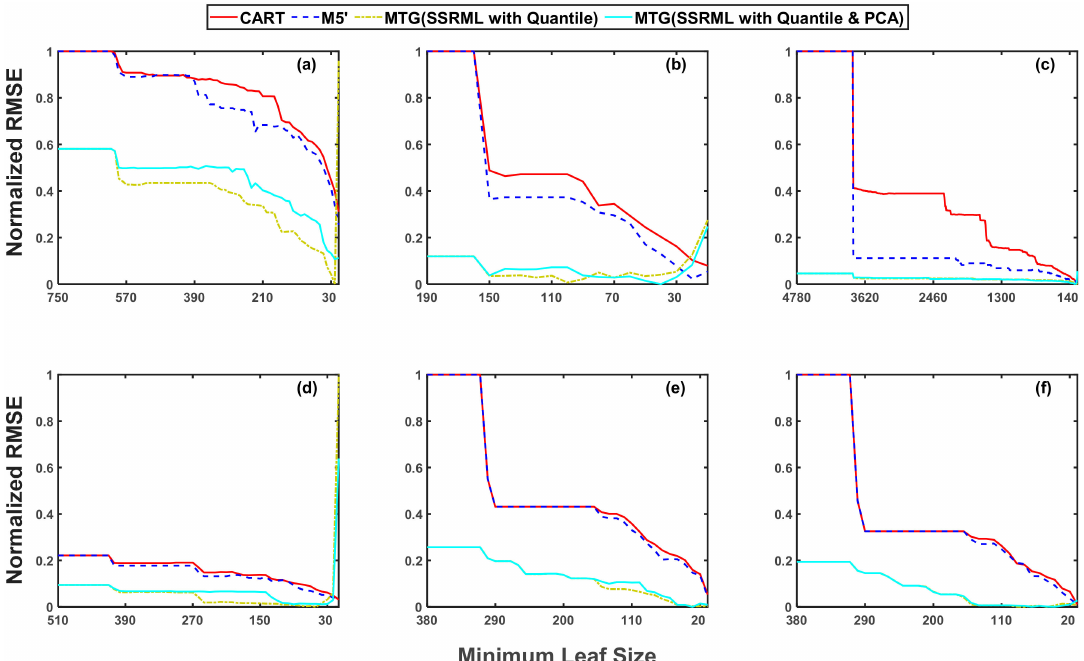
Figure 6. The normalized RMSE values against minimum leaf size in descending order for; ( a ) airfoil self-noise, ( b ) auto MPG, ( c ) combined cycle power plant; ( d ) concrete compressive strength, ( e ) energy e ffi ciency (heating load) and ( f ) energy e ffi ciency (cooling